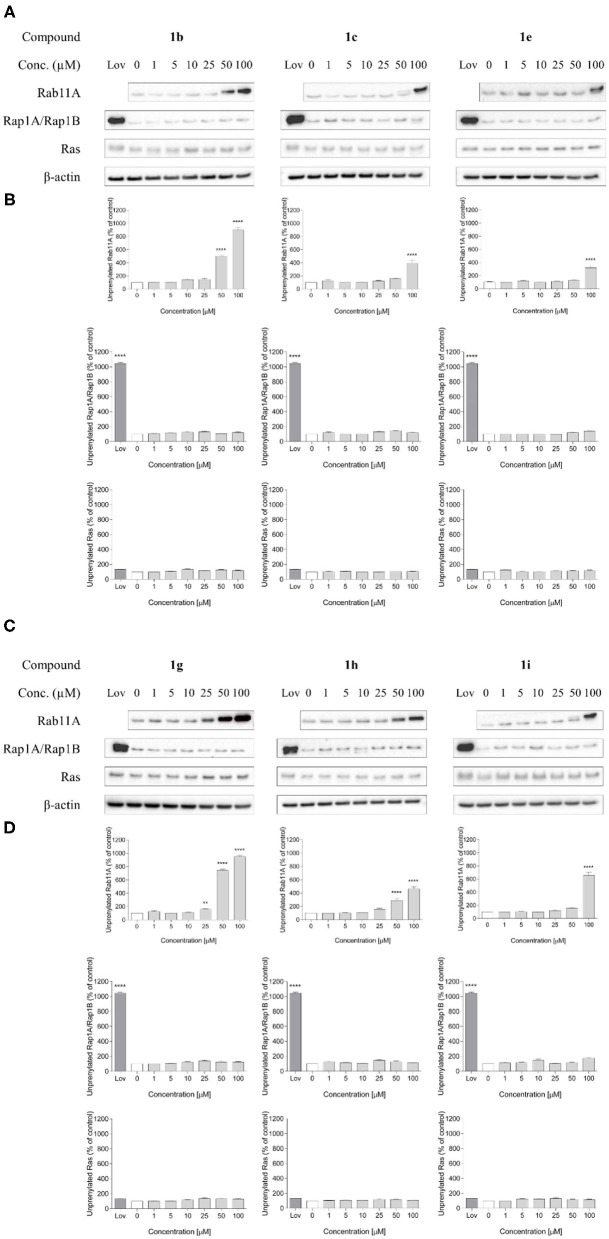
Effect of 6-substituted 3-IPEHPC analogs with iodo (1b), carboxyl (1c), amide (1e), 3- and 4-formylphenyl (1g–h), or 3-acetylphenyl (1i) group on Rab11A, Rap1A/Rap1B, and Ras prenylation in HeLa cells. Cells were exposed to indicated concentrations of compounds or 10 μM lovastatin (Lov) for 48 h. Subsequently, cells were lysed and isolation of cytosolic and membrane proteins was performed. Cytosolic fractions containing unprenylated proteins were western blotted for Rab11A, Rap1A/Rap1B, Ras, and β-actin (A,C), and the immunoblot bands were quantified by densitometry analysis, normalized to β-actin, and presented as a percentage of controls (B,D). Lovastatin was used as control. Even though it is the inhibitor of more upstream enzyme of mevalonate pathway, HMG-CoA reductase, and it is expected that treatment of cells with lovastatin should prevent the Ras accumulation at the membrane, we observed the failure of lovastatin to cause mislocalization of Ras. However, our observations of the lack of Ras inhibition by lovastatin in HeLa cells is in accordance with the results of Tennakoon et al. (2019). They compared how different statins (fluvastatin, atorvastatin, lovastatin) attenuate prenylation of Ras superfamily members in HeLa cells, showing that HeLa cells exposed to lovastatin exhibited negligible inhibition of both Ras members. Data represented mean ± SEM from at least three independent experiments; *p ≤ 0.05, **p ≤ 0.01, ***p ≤ 0.001, and ****p ≤ 0.0001.